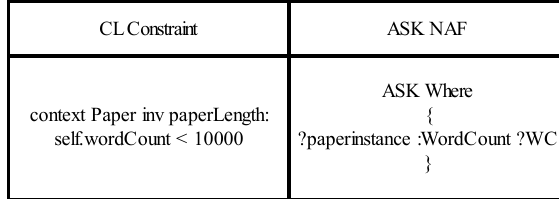
TABLE 2. TRANSFORMATION OF OCL